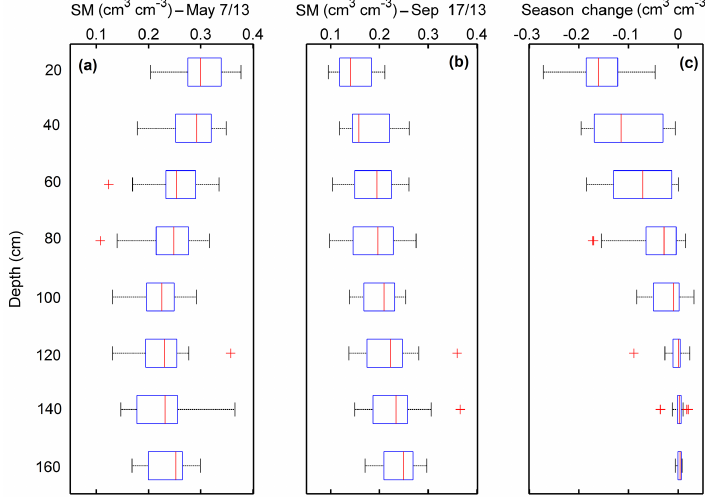
Figure 3. Spatial variability of soil moisture with depth; volumetric water content for 7 May 2013 and 17 September 2013, and season change (difference between 17 September 2013 and 7 May 2013). The boxplot indicates the median (red line), 25th and 75th percentile (edges of the box), and minimum and maximum (extent of whiskers)